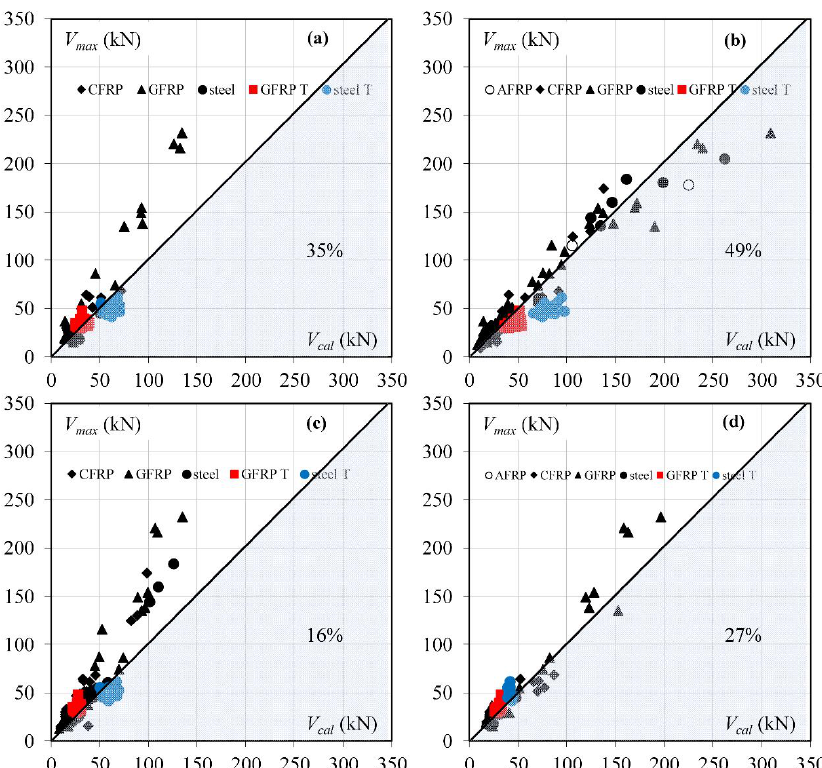
Figure 2. The comparison of experimental and calculated shear capacity according to the presented models (percentage points indicate overestimated results V cal > V max ): ( a ) Muttoni and Ruiz [11], ( b ) Zhang et al. [12], ( c ) Yang [13], ( d ) Cladera et al. [14].